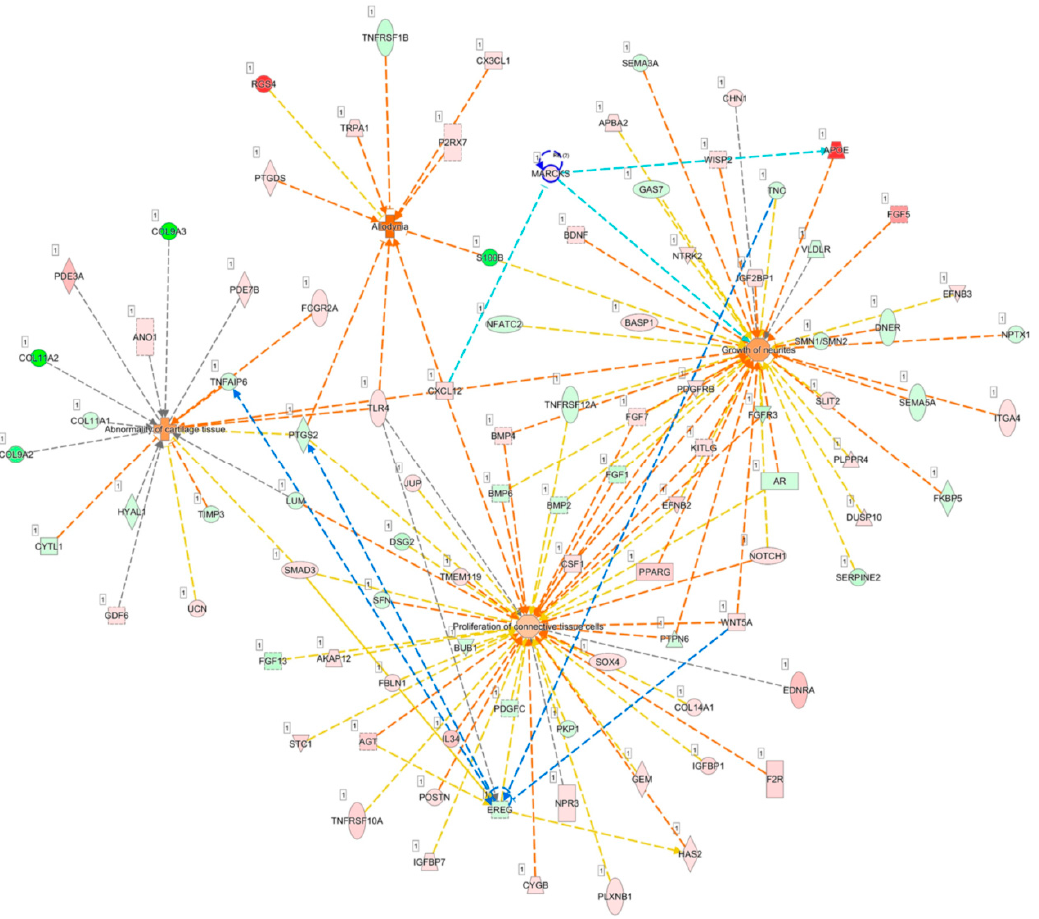
Figure 8. Analysis of the potential connections between MARCKS , EREG and OA joint pain condition. The merged network of genes related to the abnormality of cartilage tissue, proliferation of connective tissue cells, growth of neurites, and allodynia categorized from differentially expressed genes of OA knee chondrocytes by IPA software is shown. MARCKS was connected to APOE and CXCL12 , as indicated in light blue lines, where CXCL12 was demonstrated to be simultaneously involved in all four networks. EREG was mainly linked to WNT5A , TNC , PTGS2 , and TNFAIP6 , as indicated with blue lines.